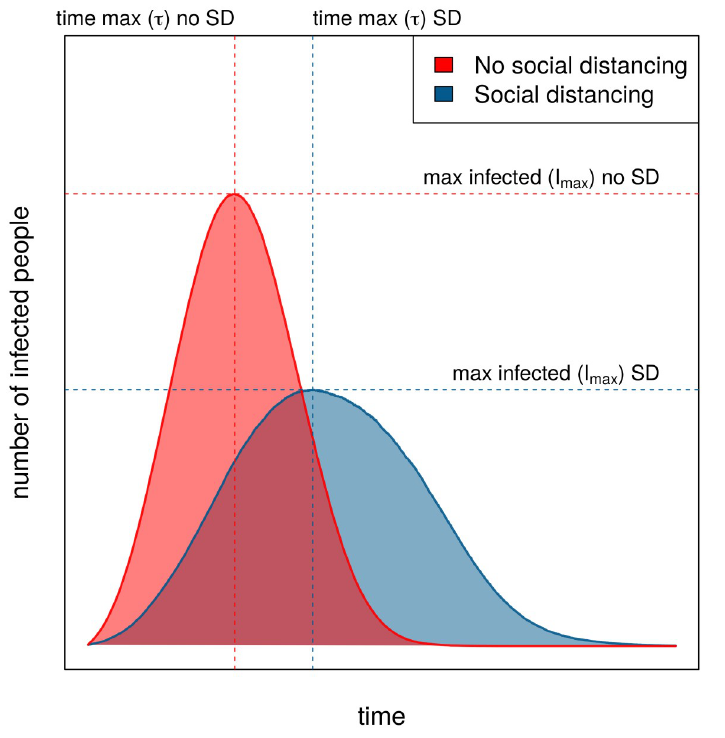
Fig 3. Illustration of the impact of social distancing on the spread of the